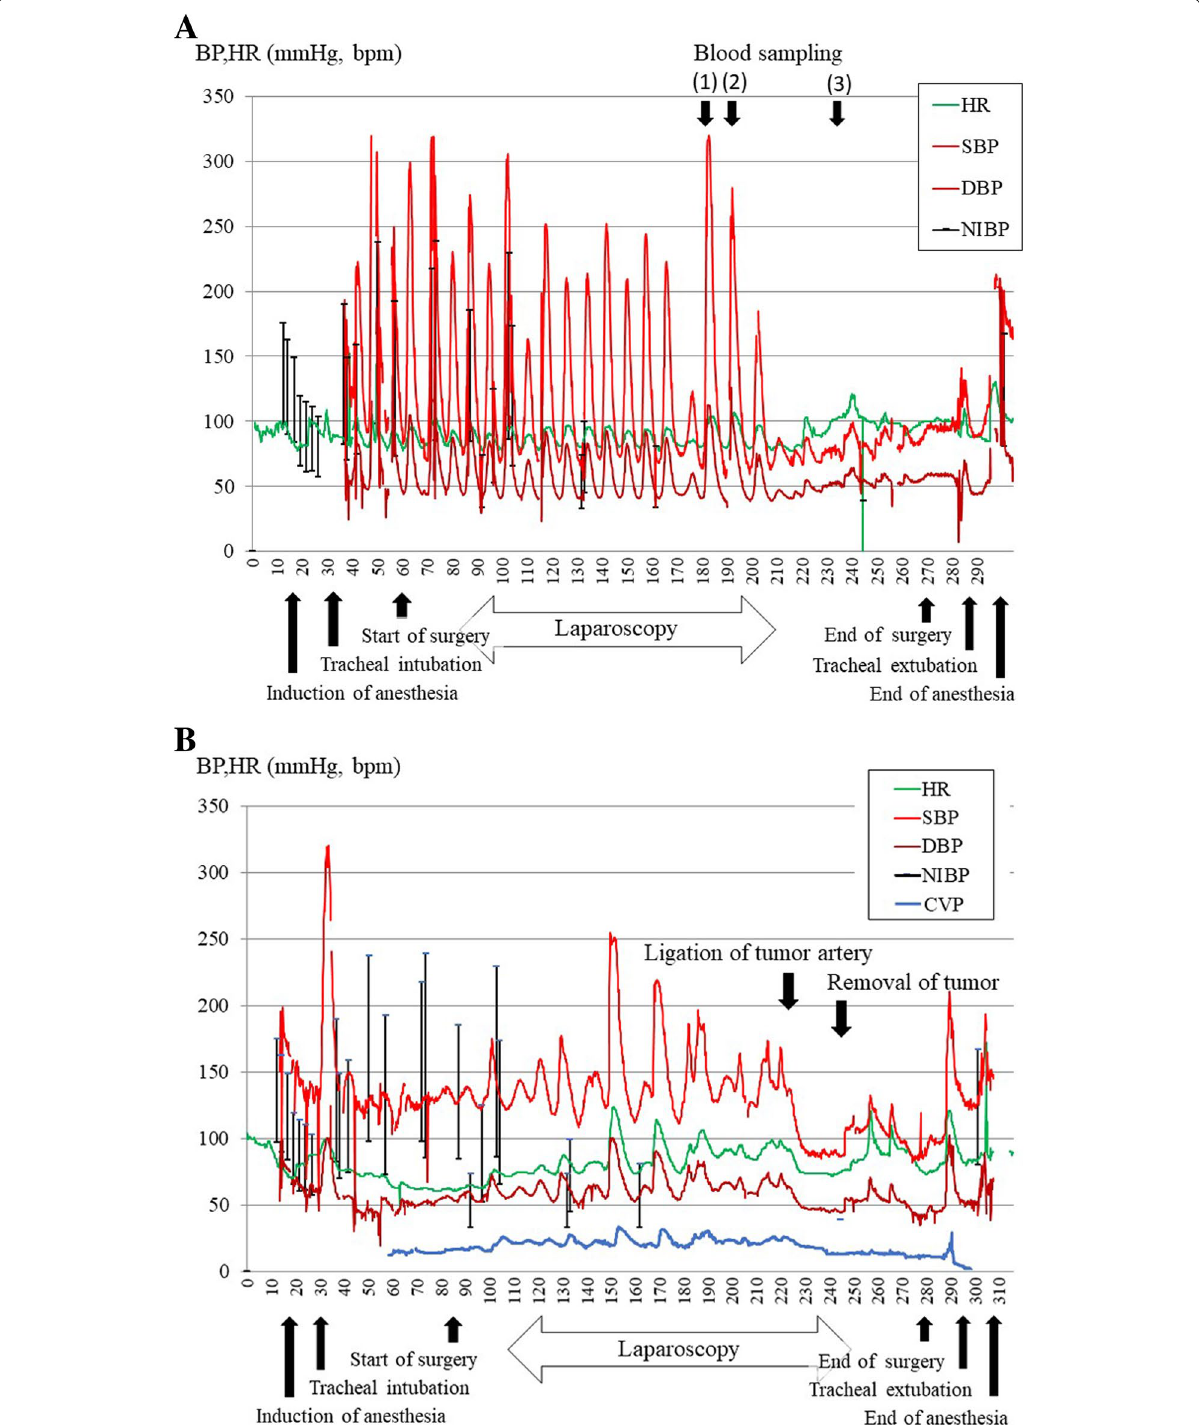
Fig. 1 Anesthesia record of the first ( A ) and the second surgery ( B ). A Periodic blood pressure fluctuations occurred after tracheal intubation, lasted approximately for 150 min, and subsided at the end of laparoscopic surgery. Levels of adrenaline, noradrenaline, and dopamine were 3.22, 1.98, and 0.02 ng/ml at the point of [1], 6.32, 3.12, and 0.02 ng/ml [2] and 0.36, 0.47, and 0.02 ng/ml [3], respectively. B Periodic blood pressure fluctuations occurred after anesthesia induction, lasted approximately for 200 min, and disappeared after pheochromocytoma resection. The fluctuations were approximately 10 min apart, and the degree was smaller than that of the first